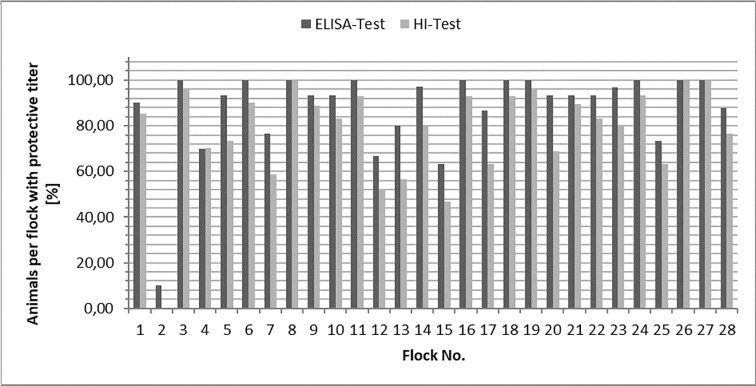
Proportion of animals with protective titer in ELISA and HI test.